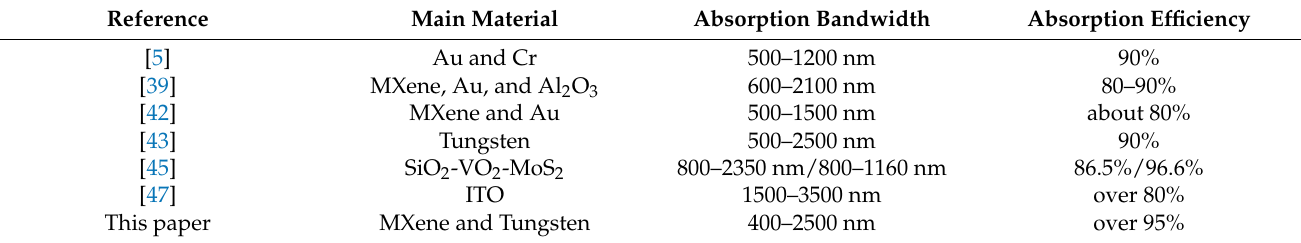
Table 1. Comparison of the absorber in this paper with the published broadband absorbers in visible and near-infrared